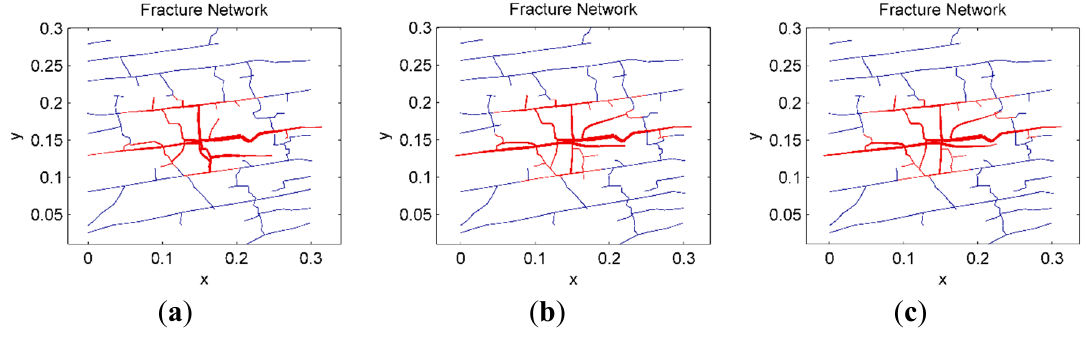
Figure 10. Fracture configurations under σ the fluid injection are colored red and other fractures are colored blue: ( a ) σ ( b ) σ (cid:3404) 30 MPa ; ( c ) σ (cid:3051)